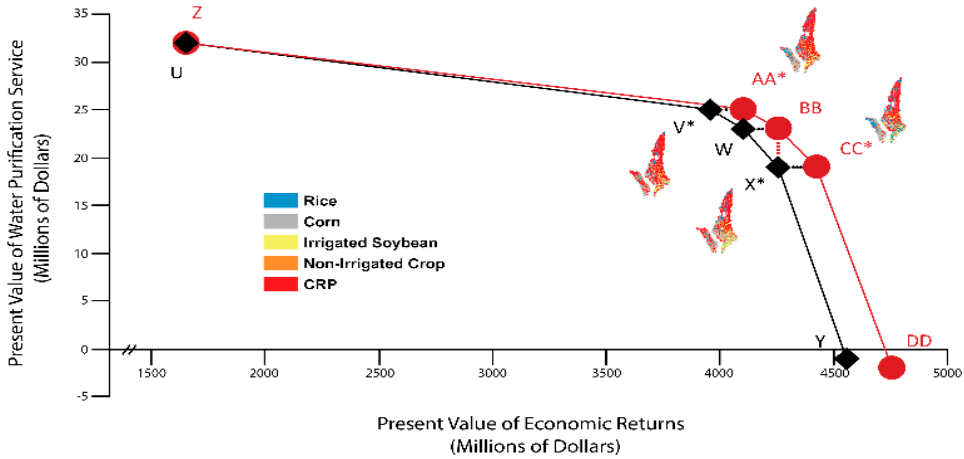
Figure 4. Crop mix patterns associated with specific points along the efficiency frontiers without reservoirs and with reservoirs that show the tradeoff of economic returns and water purification value. Each crop mix pattern shown beside the efficiency frontiers correspond to a lettered point with an asterisk on the frontiers. Efficiency frontiers are closer together than in Figure 2 indicating reservoirs do not have much influence on economic efficiency when only water purification matters.